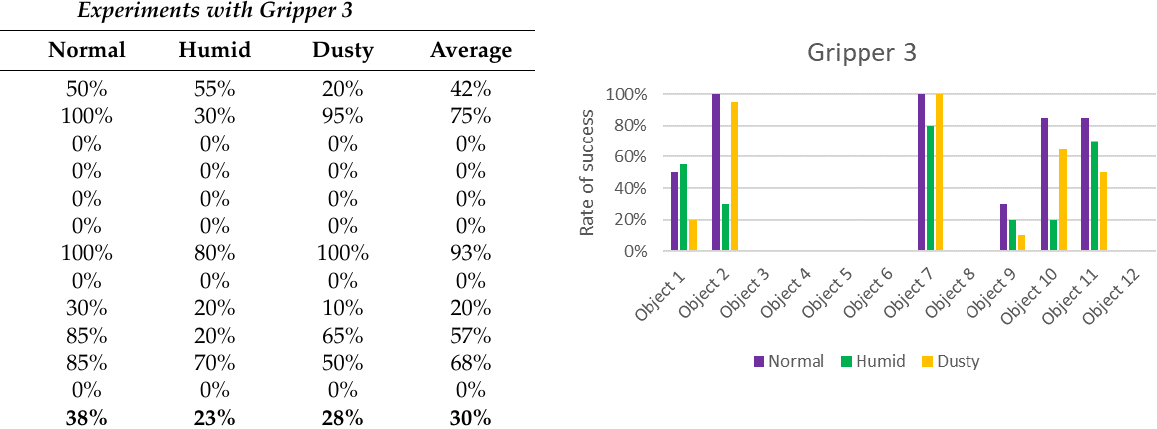
Table 4. Experiments with Gripper 3. On the left, the table with success rate for every object, in the last column, the average for every object is calculated, and at the end of the table, the average success rate for every environment is determined. On the right, the graphic representation of Table 4 is reported.